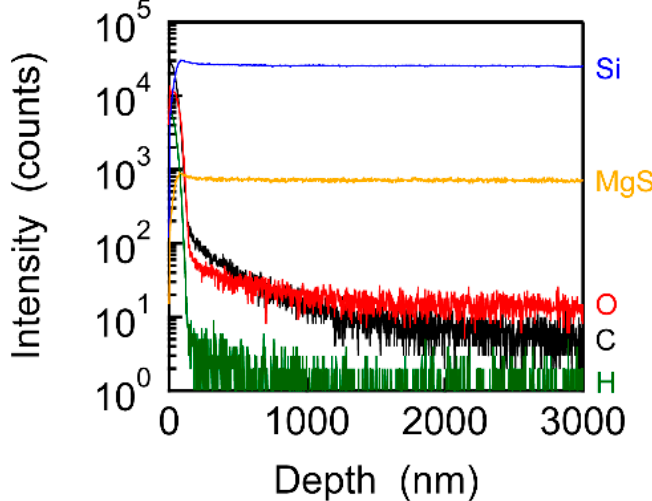
Figure 3. Depth profiles of O, C, H, Si, and MgSi of the Mg 2 Si SC.